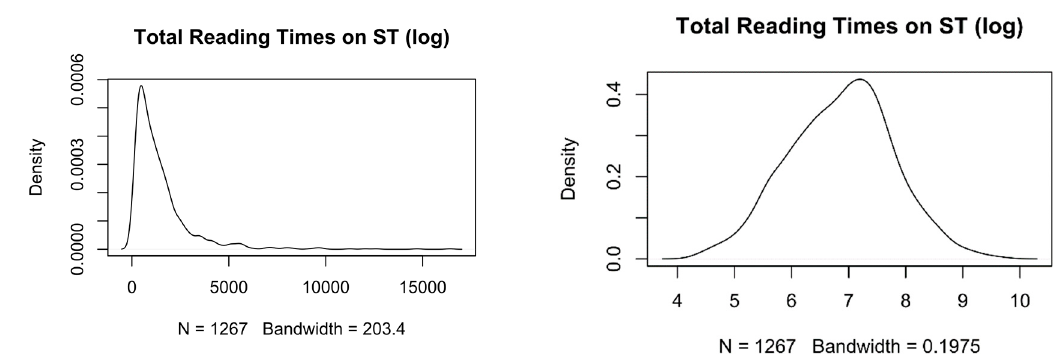
Figure 5. Density total reading times on ST ( left ) and the same density log-transformed ( right ).